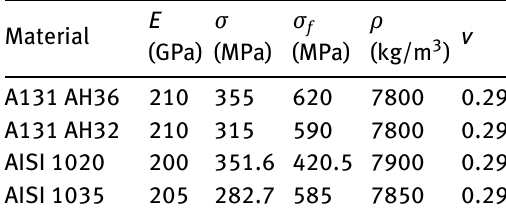
Table 2: Mechanical properties of each material.